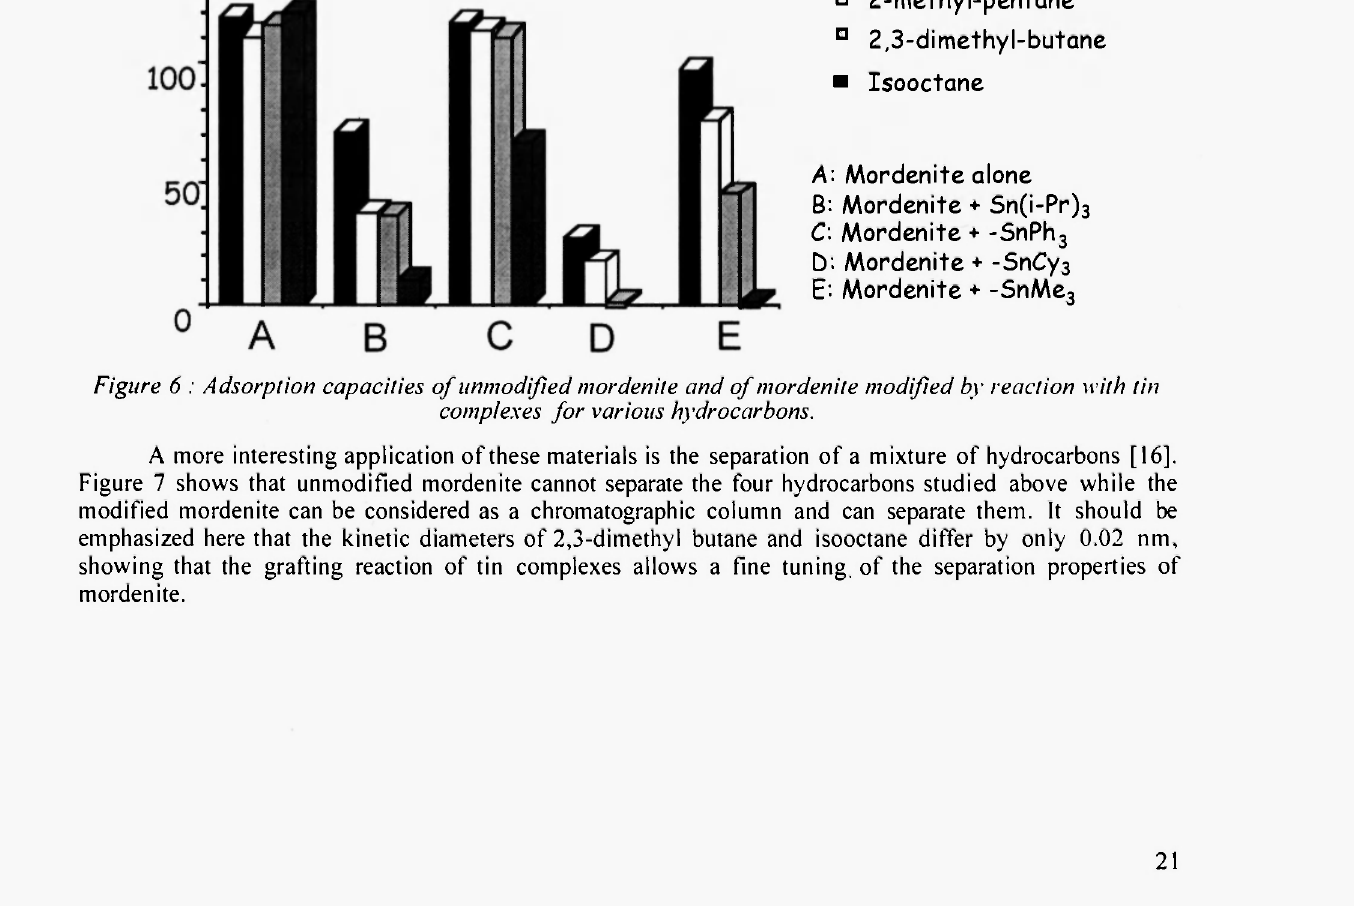
Figure 5 : Pore entrance of mordenite after reaction with tetrabutyltin.